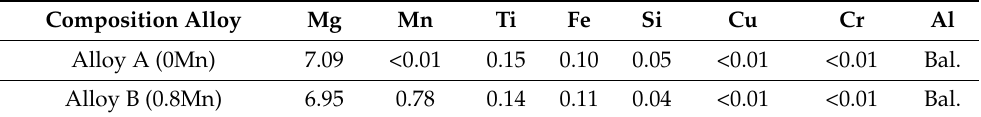
Table 3. Alloy Composition (wt.%).